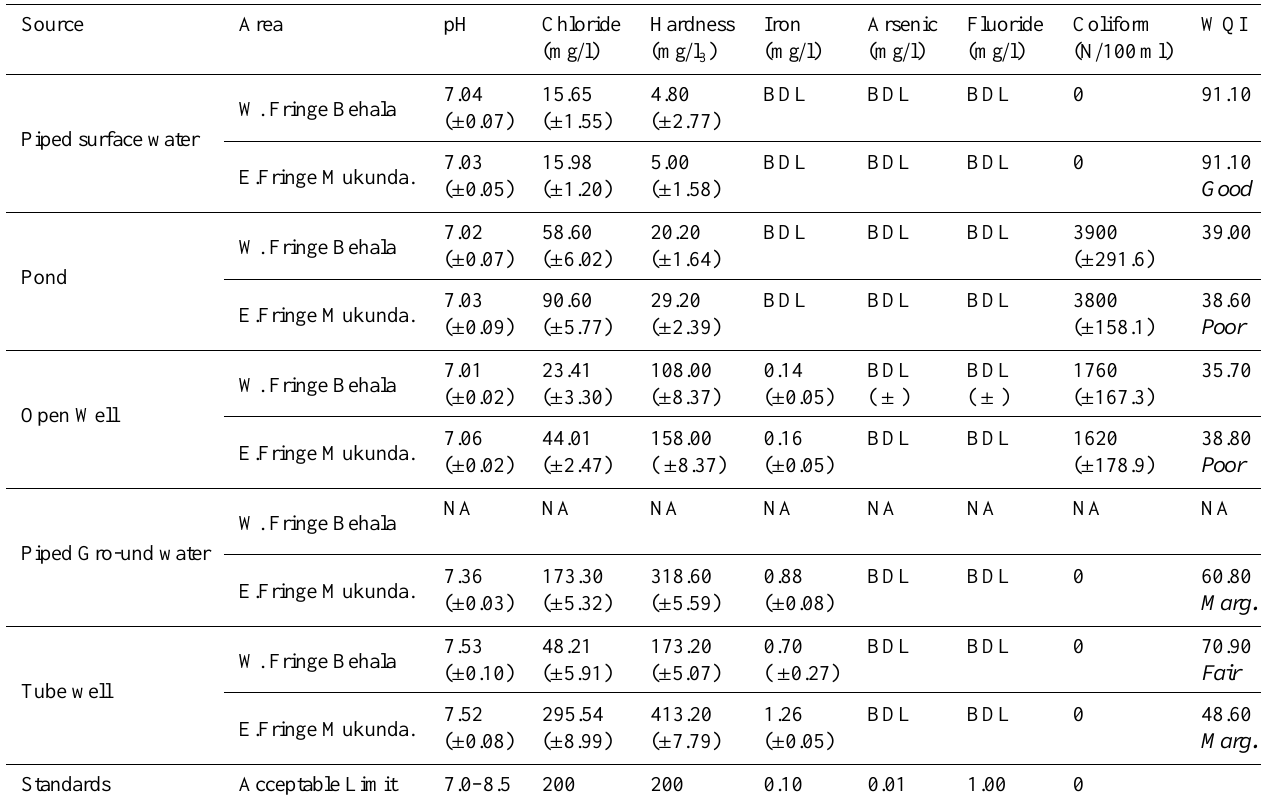
Table 3. Water quality observed in southern fringes of